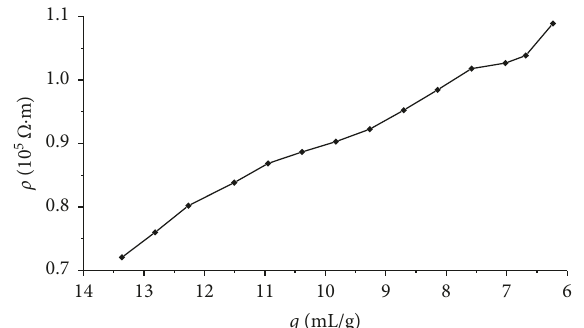
Figure 7: Corresponding resistivity change for two modes of adsorbing the same gas content. Figure 5: Resistivity vs. gas content during isovolumetric